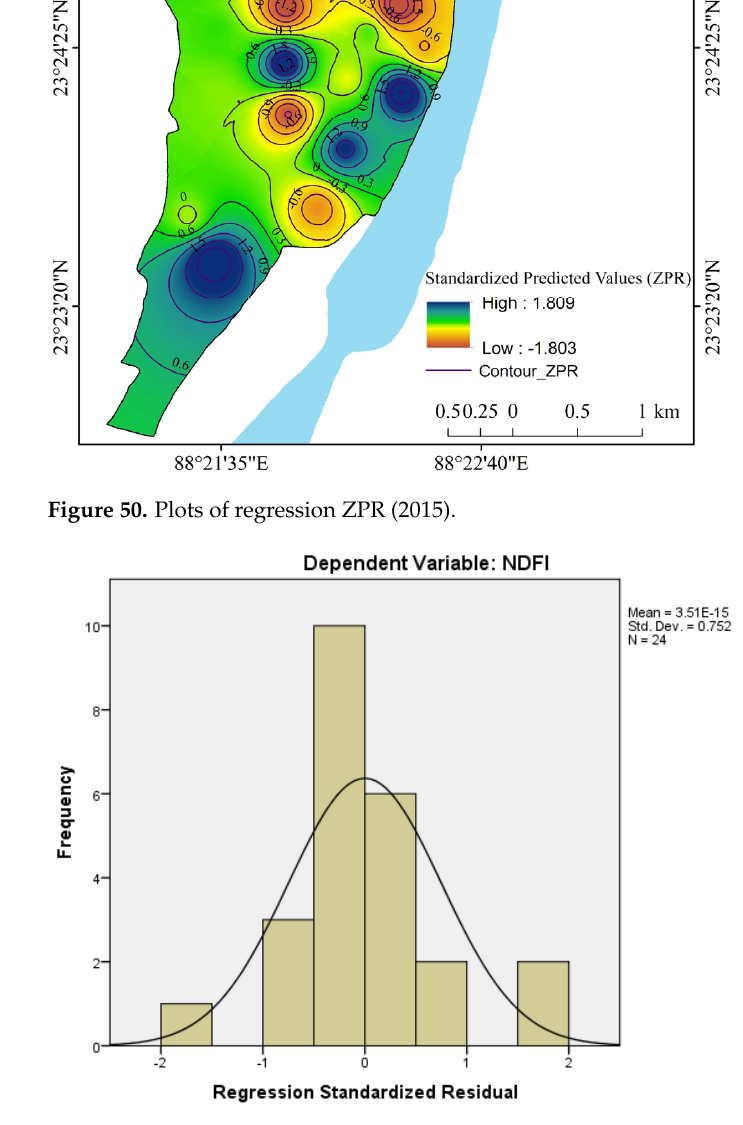
Figure 51. Frequency distribution of regression ZRE.